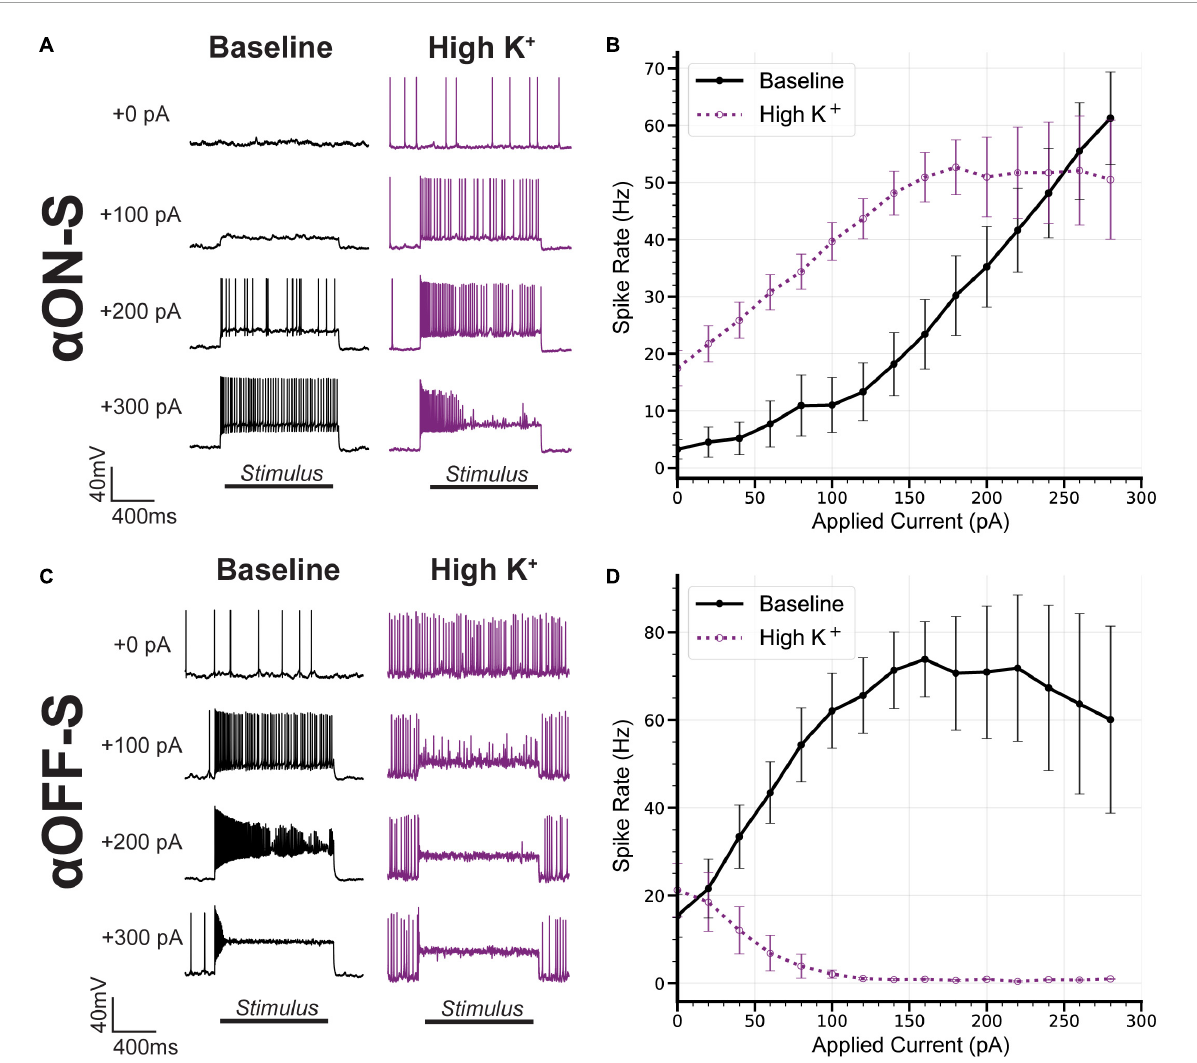
FIGURE5 Alpha OFF-sustained ( α OFF-S) firing dynamics are more sensitive to elevated extracellular potassium. (A) Representative current-clamp responses of alpha ON-sustained ( α ON-S) cells to 0, 100, 200, and 300 pA pulses, before and after washing on high K + . (B) The current-spiking relationship for α ON-S before and after high K + . High extracellular K + significantly alters the current-spiking relationship (two-way ANOVA, potassium-stimulation interaction effect p = 0.0397). Elevated potassium increases the firing rate of α ON-S retinal ganglion cells (RGCs) at most current steps but induces a plateau and decrease in rate with variably widened and failed action potentials with stronger depolarizations. (C) Representative current-clamp responses of α OFF-S cells to 0, 100, 200, and 300 pA pulses, before and after washing on high K + . (D) The current-spiking relationship for α OFF-S before and after high K + . High extracellular K + significantly alters the current-spiking relationship (two-way ANOVA, Potassium effect p = 0.0005). In the presence of elevated K + , the rates of α OFF-S cells are significantly decreased and quickly drop to zero with increased stimulation, with many failed action potentials. Error bars: ± standard error of the